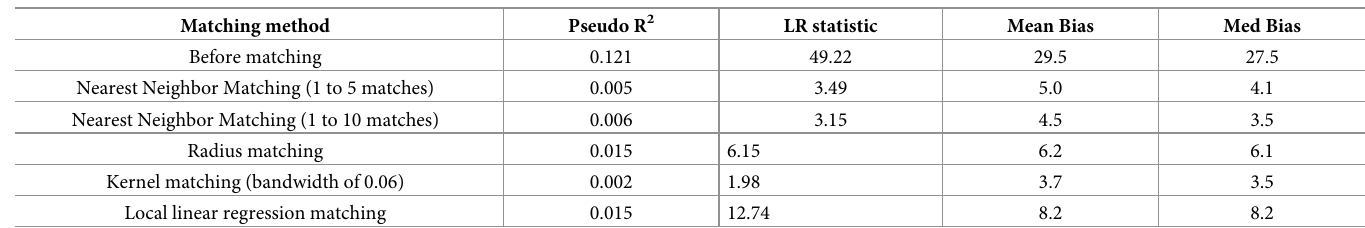
Table 7. Sample matching methods and their balance test results.